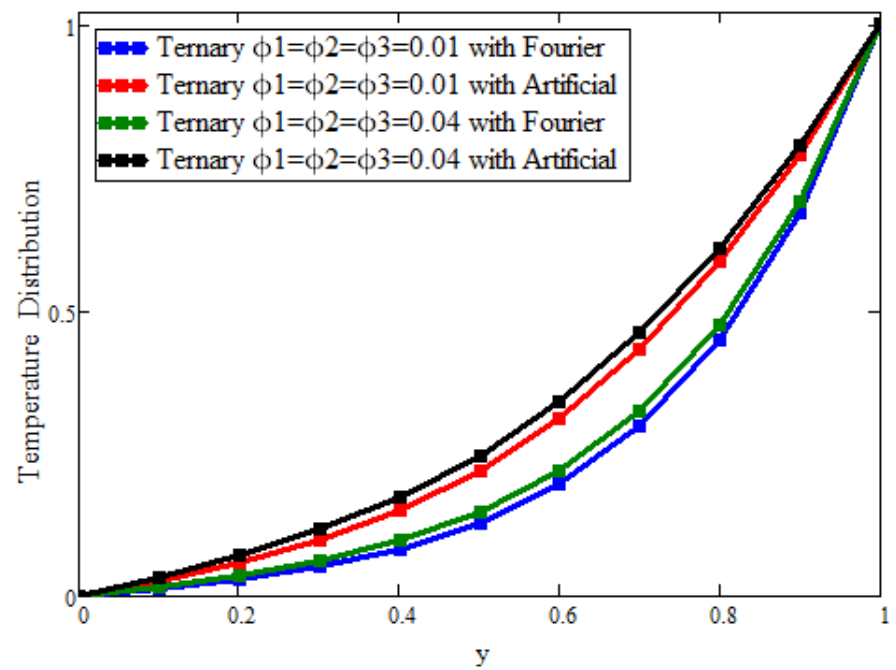
Figure 6. The effect of the volumetric fraction on the temperature field. Here, Pr = 21, γ = 0.7, α = 0.7, β = 0.7, a = 0.02, and t =